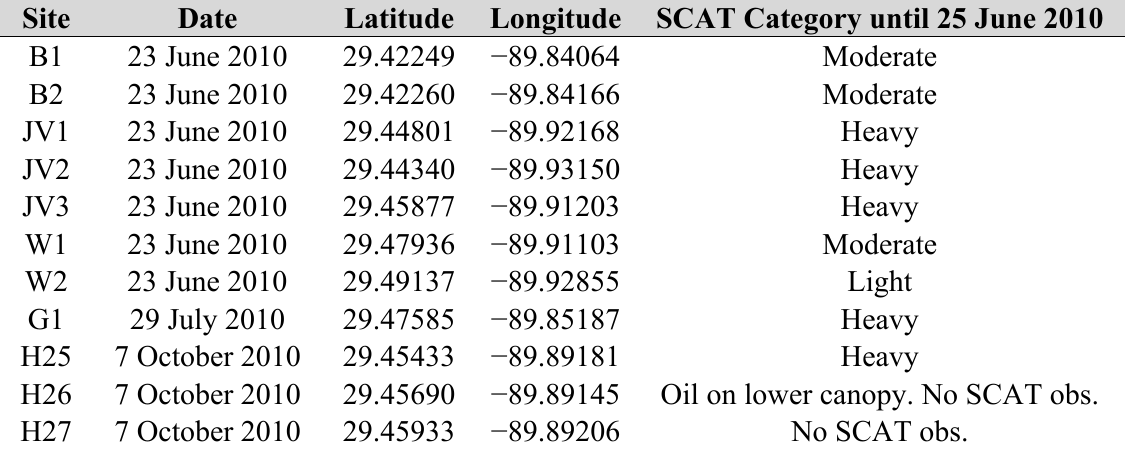
Table 2. Locations of ground-based observations of oil impacts from the Deepwater Horizon spill, along with shoreline-impact descriptions. Site locations are shown in Figure